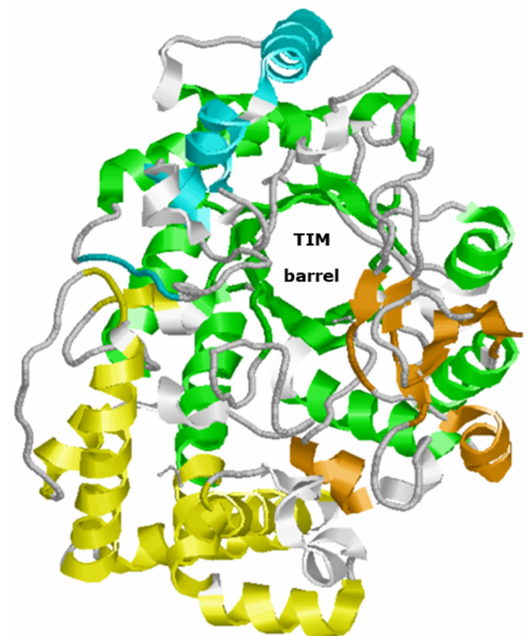
Figure 2. 3D structure of T. thermophilus amylomaltase. The 1ESW structure was downloaded from PDB and coloured using RasMol [52]. Green elements correspond to the domain A (TIM-barrel). The other coloured elements correspond to subdomain B1 (orange), subdomain B2 (yellow), and subdomain B3 (cyan). Domains and colours are as reported by Przylas et al. [51]. The main functional elements (active site, 250s loop, secondary substrate binding site) are further detailed in Section